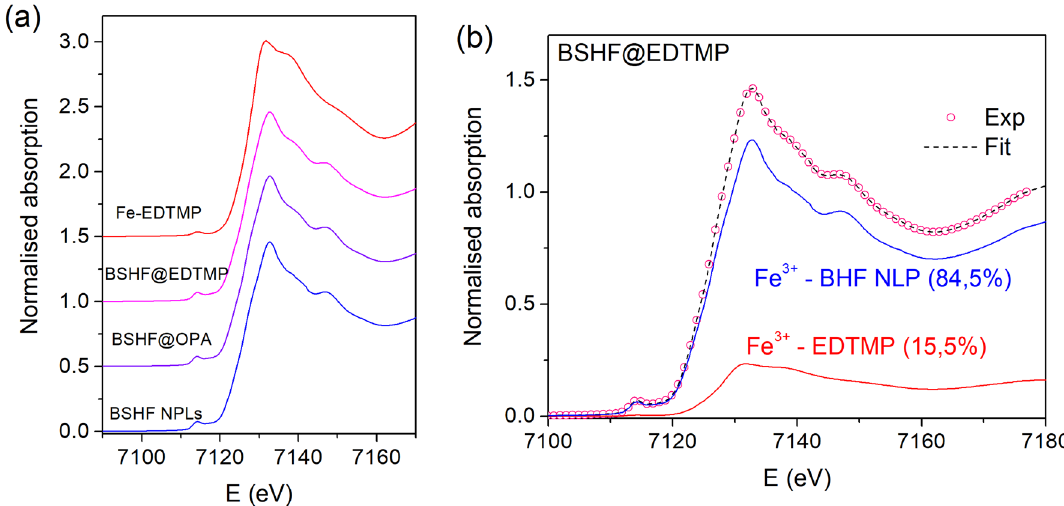
Figure 6. ( a ) Fe K-edge XANES spectra of the EDTMP and OPA coated BSHF NPLs and the reference spectra of uncoated BSHF NPL sample and Fe–EDTMP complex. The spectra are shifted vertically for clarity. ( b ) LCF analysis of the BSHF@EDTMP spectrum: red circles—experiment; blue dashed line—best fit with a linear combination of reference XANES profiles of BSHF NPLs (84.5%) and Fe–EDTMP complex (15.5%), plotted